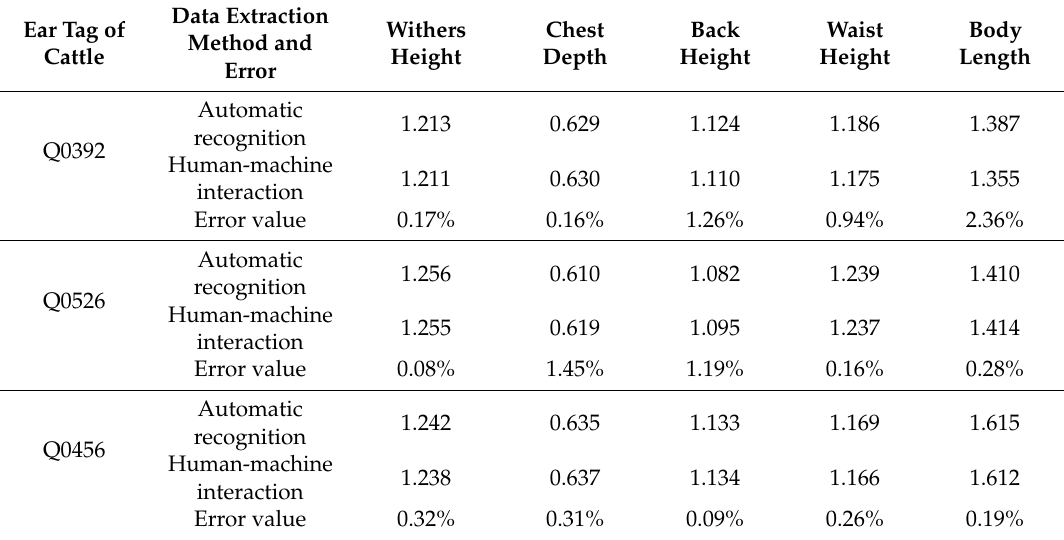
Table 4. The data and error values of the body dimensions of the three cattle (unit: